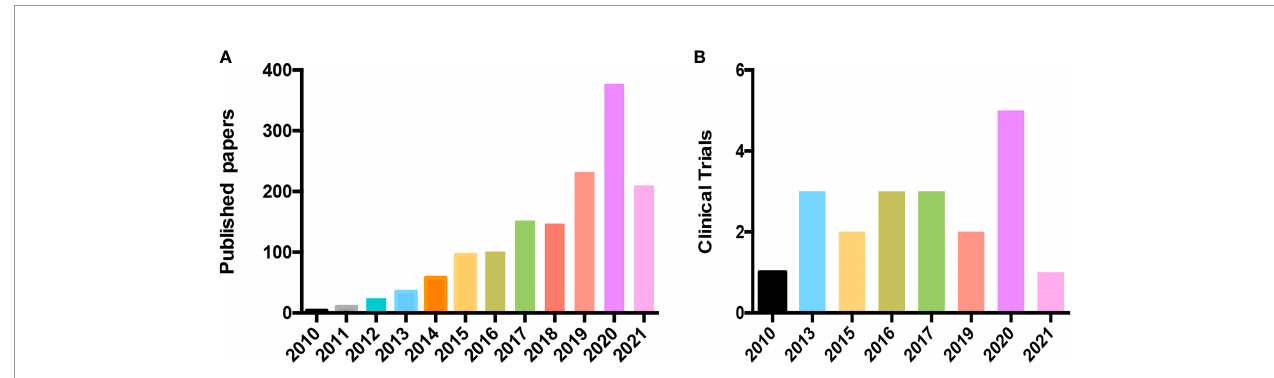
FIGURE 1 | Drug repositioning in cancer has increased its relevance and popularity in recent years. (A) Papers published in PubMed in the last decade (B) Clinical Trials of the last